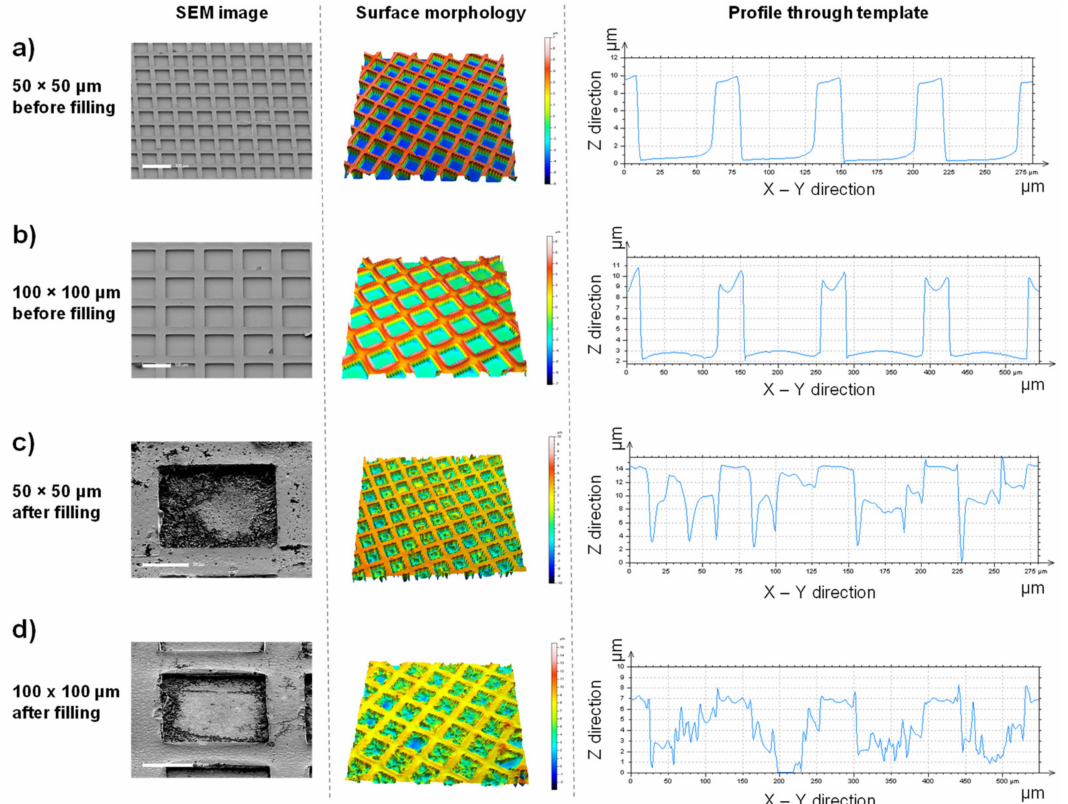
Figure 2. Well-defined microscale templates can easily be filled with a hydrogel precursor solution. Scanning electron microscope (SEM) images (left panel) with corresponding multi-pinhole confocal microscopy height maps (middle panel) and cross-sectional data (right panel) show unfilled templates of 50 µ m ( a ) and 100 µ m ( b ) widths. Analysis of the filling of these templates was performed after hydrogel formation but before template removal, for both 50 µ m- ( c ) and 100 µ m- ( d ) width templates. Scale bars represent 100 µ m ( a , b ), 20 µ m ( c ), and 50 µ m ( d